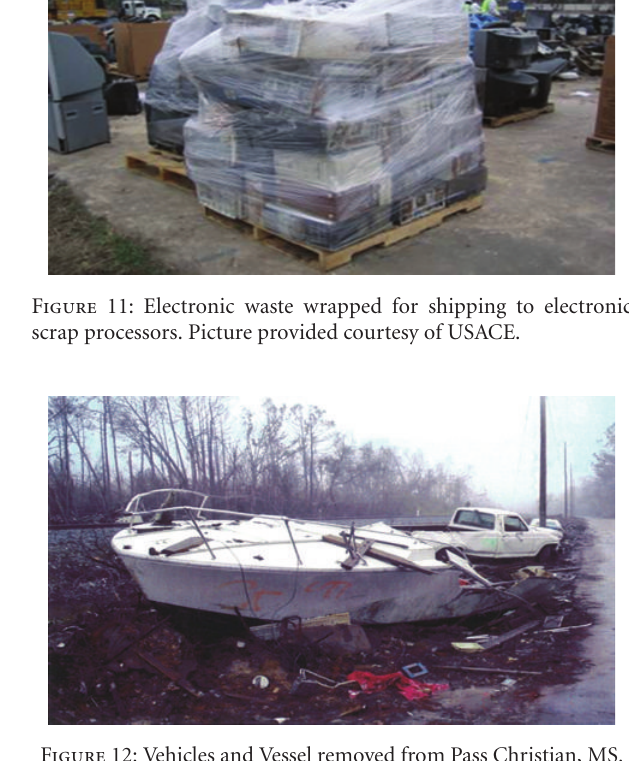
Figure 10: Collection of electronic waste. Picture provided courtesy of USACE.